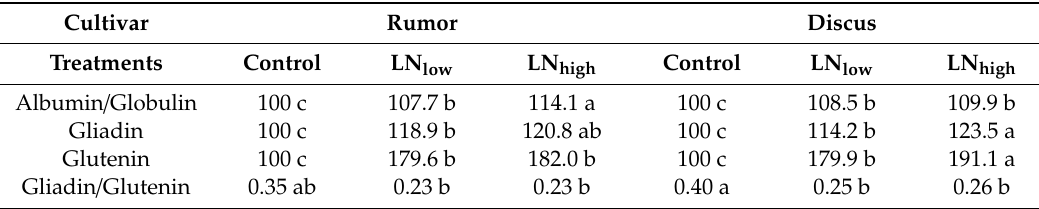
Different small letters within rows indicate significant differences between all treatment combinations ( p ≤ 0.05).